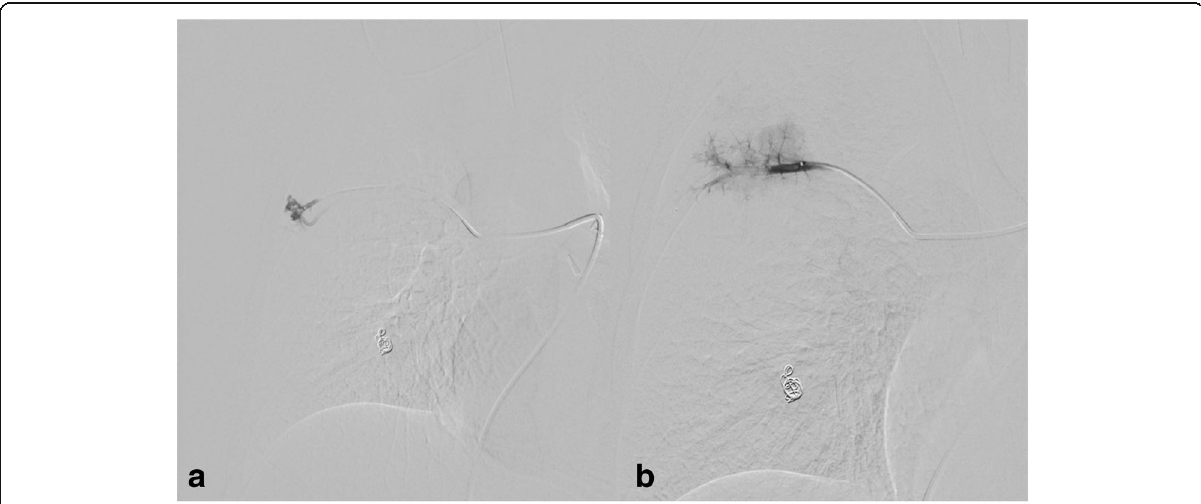
Fig. 4 a Before deployment of MVP-5Q. b After deployment of MVP-5Q, immediate stop of